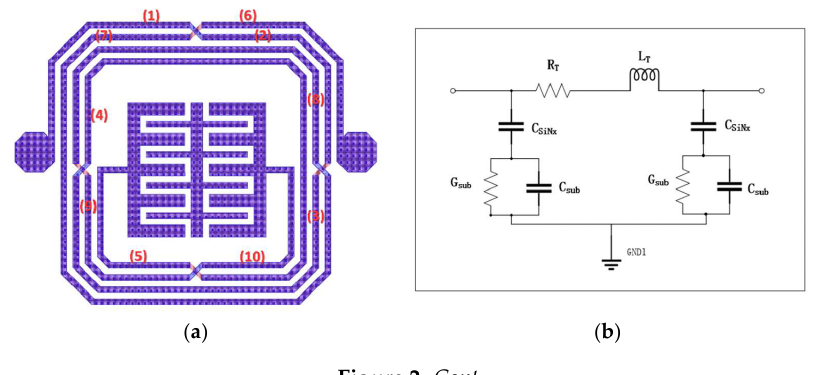
Figure 1. Design of the proposed bandpass filter (BPF): ( a ) 3D view of the packaged BPF on a printed circuit board (PCB) board; ( b ) enlarged view; ( c ) side view; ( d ) three metal layers (leads, text, and